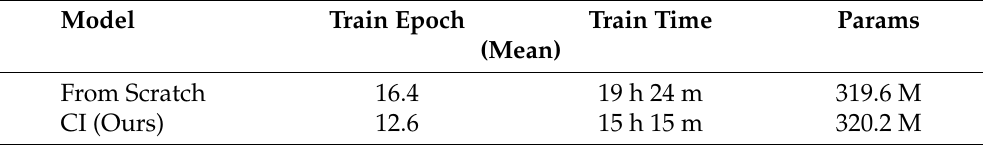
Table 8. Comparison of training cost and parameters of ORT structure for two models, From Scratch and CI. Training seven times for each model.